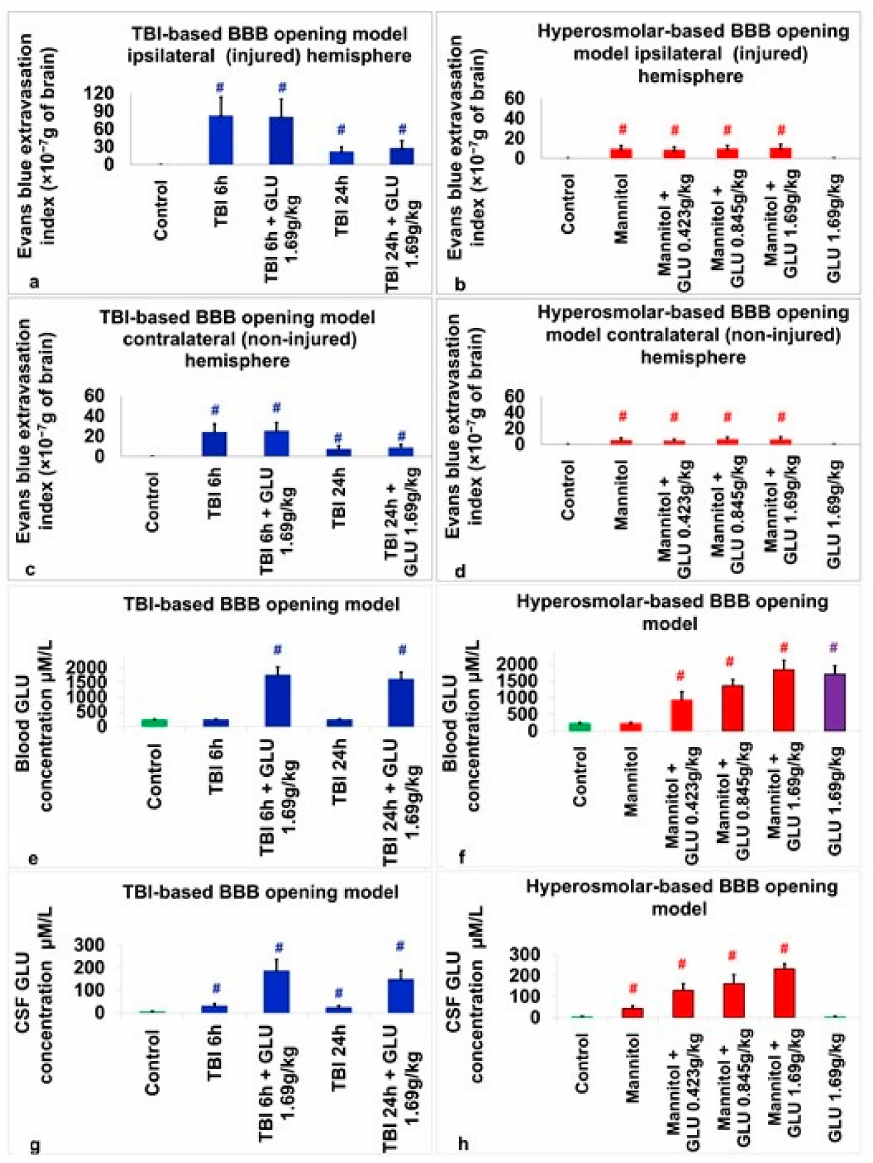
Figure 1. Changes in the brain and blood glutamate concentrations and outcomes in histological assessments of BBB breakdown in study groups compared to control groups. ( a ) Evans blue extravasa- tion index in the injured hemisphere between groups for the TBI-based BBB opening model. ( b ) Evans blue extravasation index in the injured hemisphere between groups for the hyperosmolar-based BBB opening model. ( c ) Evans blue extravasation in the non-injured hemisphere between groups for the TBI-based BBB opening model. ( d ) Evans blue extravasation index in the non-injured hemisphere between groups for the hyperosmolar-based BBB opening model. ( e ) Blood glutamate concentrations between groups for the TBI-based BBB opening model. ( f ) Blood glutamate concentrations between groups for the hyperosmolar-based BBB opening model. ( g ) CSF glutamate concentrations between groups for the TBI-based BBB opening model. ( h ) CSF glutamate concentrations between groups for the hyperosmolar-based BBB opening model. The colors used in the figure correspond to different experimental groups. Specifically, green represents the control group, red corresponds to groups where BBB disruption was induced using the hyperosmolar-based BBB opening model, blue repre- sents groups where BBB disruption was induced through the TBI-based BBB opening model, and purple represents the group that received intravenous glutamate but did not undergo BBB disruption. # p <